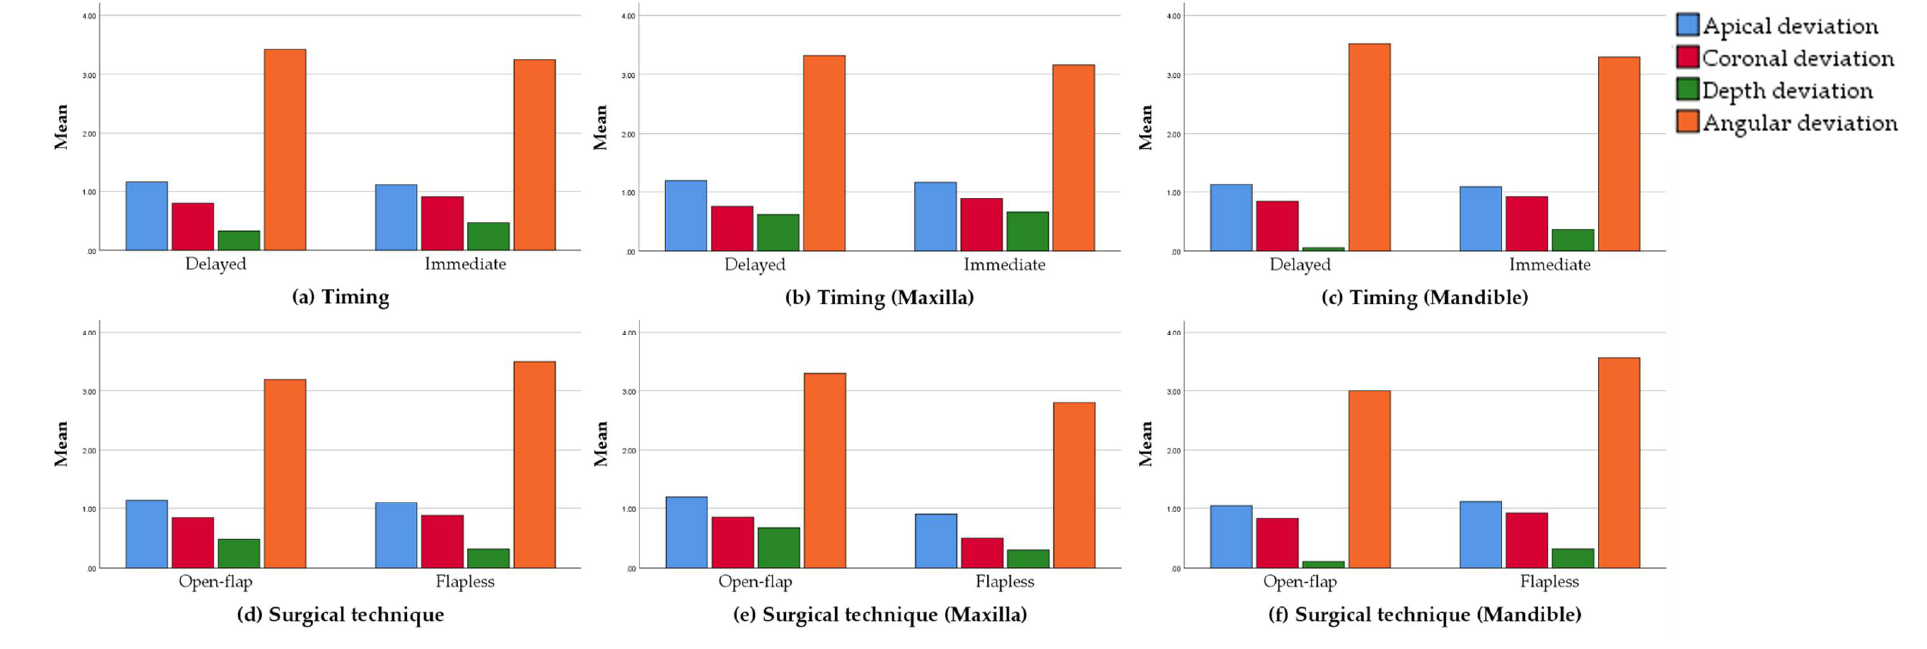
Figure 5. Deviation values of delayed and immediate groups ( a ), maxillary delayed and immediate groups ( b ) and mandible delayed and immediate groups ( c ); deviation values of open flap and flapless groups ( d ), maxillary open flap and flapless groups ( e ) and mandible open flap and flapless groups ( f ).